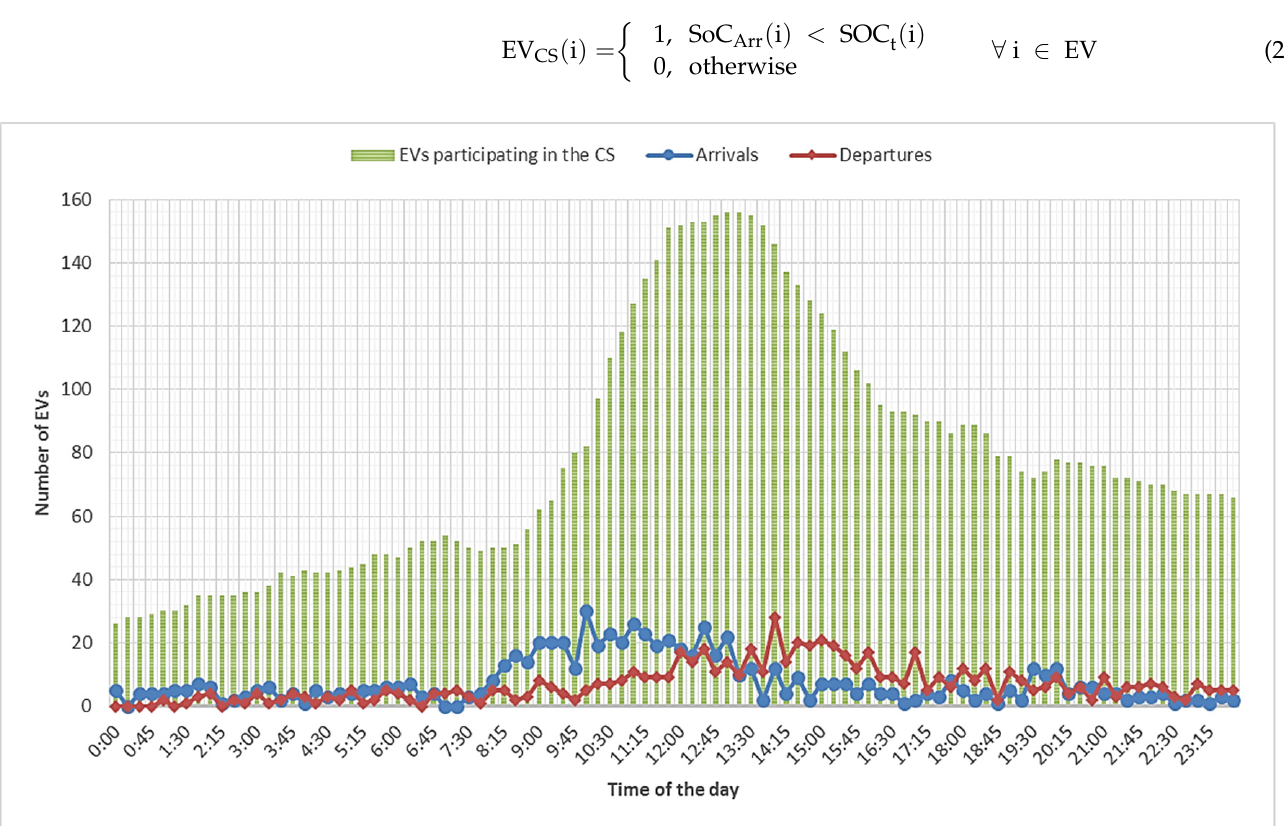
Figure 2. Numbers (per 15 min) of the arrivals, departures of EVs and the EVs participating in the proposed charging schedule.